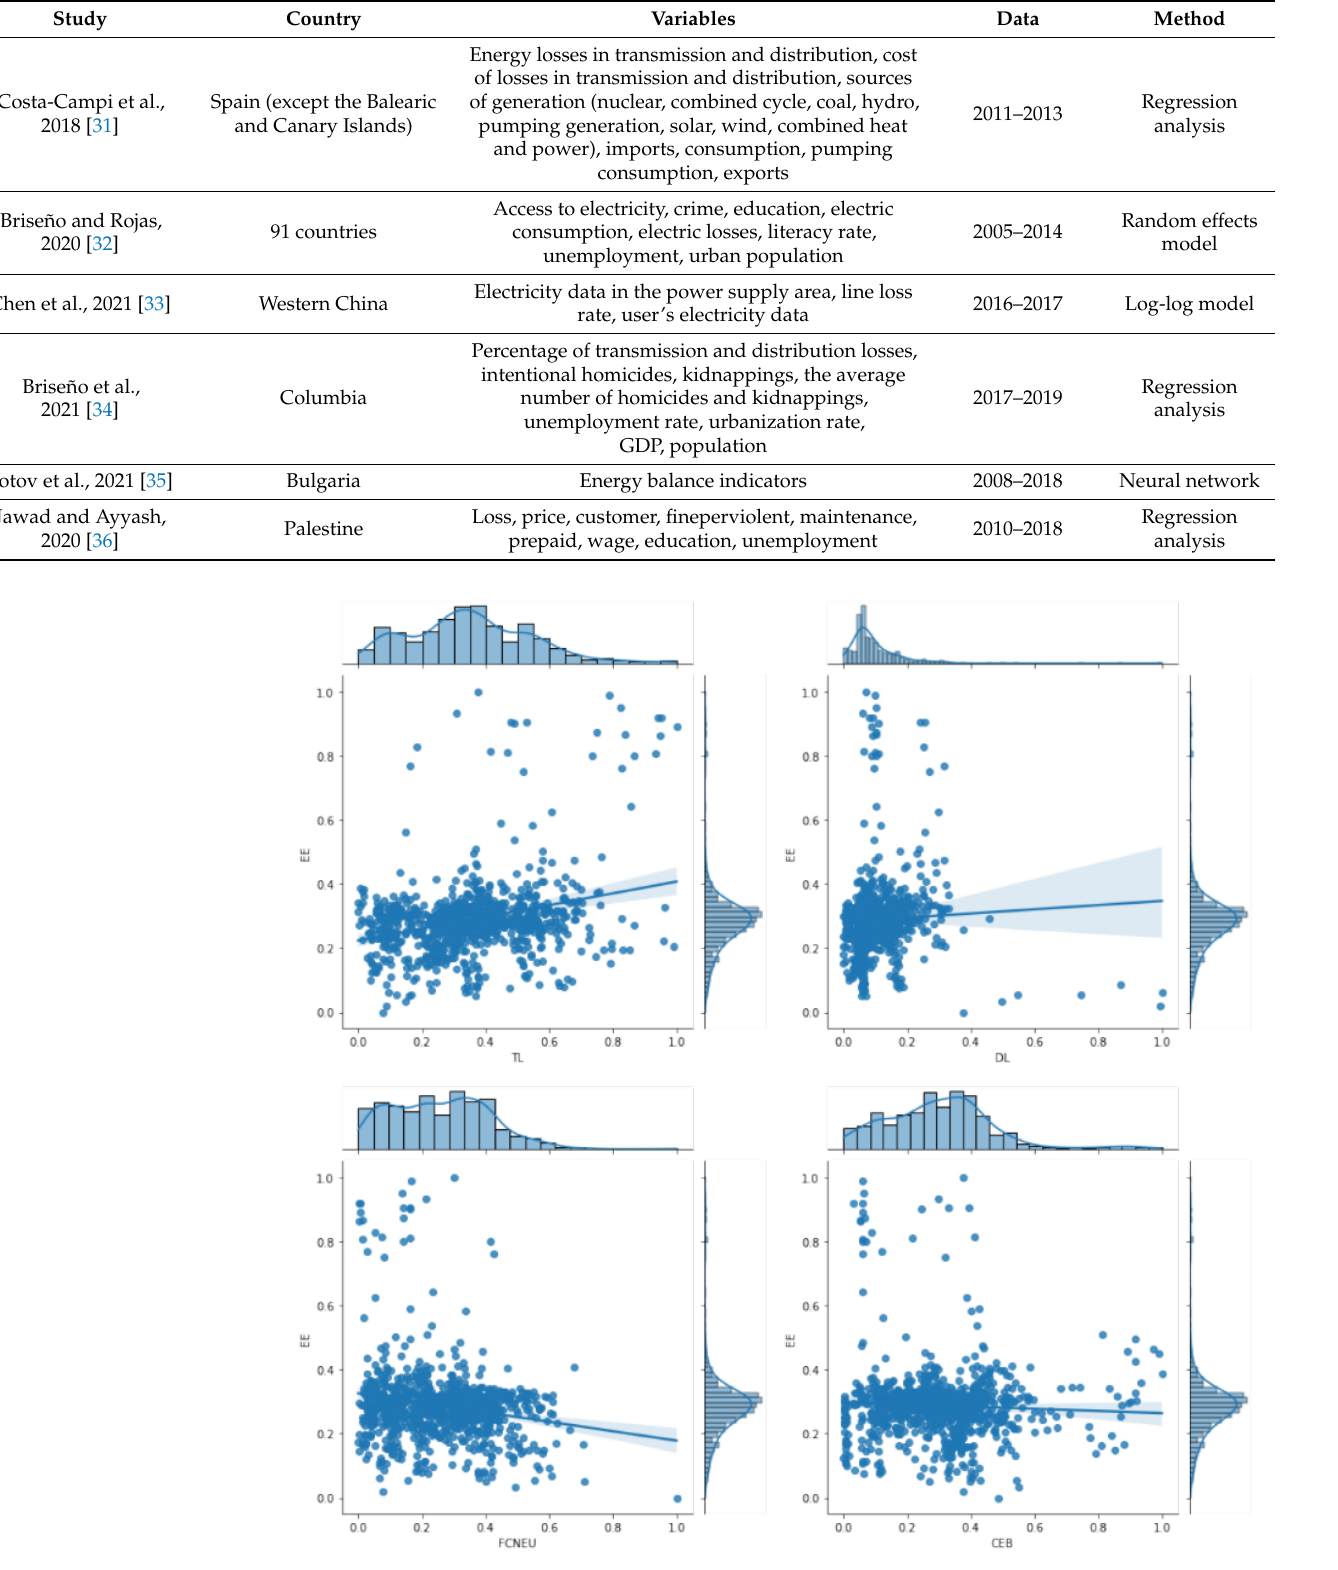
Figure 2. The scatterplots of the data with marginal histograms (based on the Eurostat’s data (ec.europa.eu/eurostat/, accessed on 17 August 2022); © European Union, 1995 – 2022).